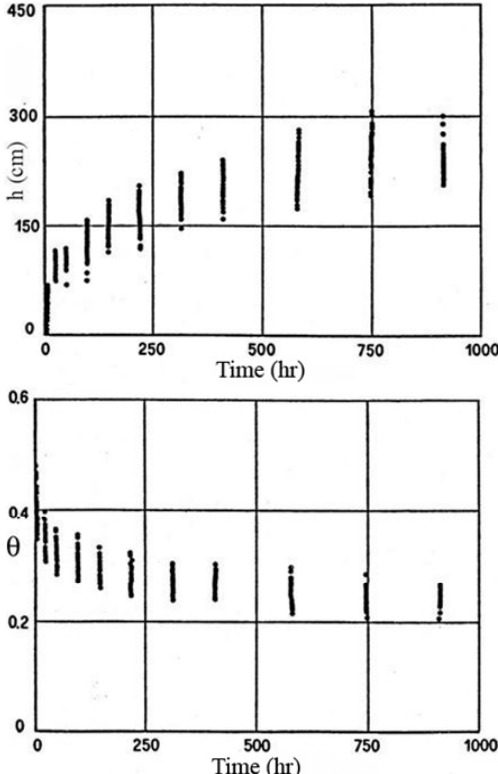
Fig. 3. Soil water tension ( h ) and volumetric water content ( θ as a function of time at the 0.3m depth for all redistribution times during the drainage